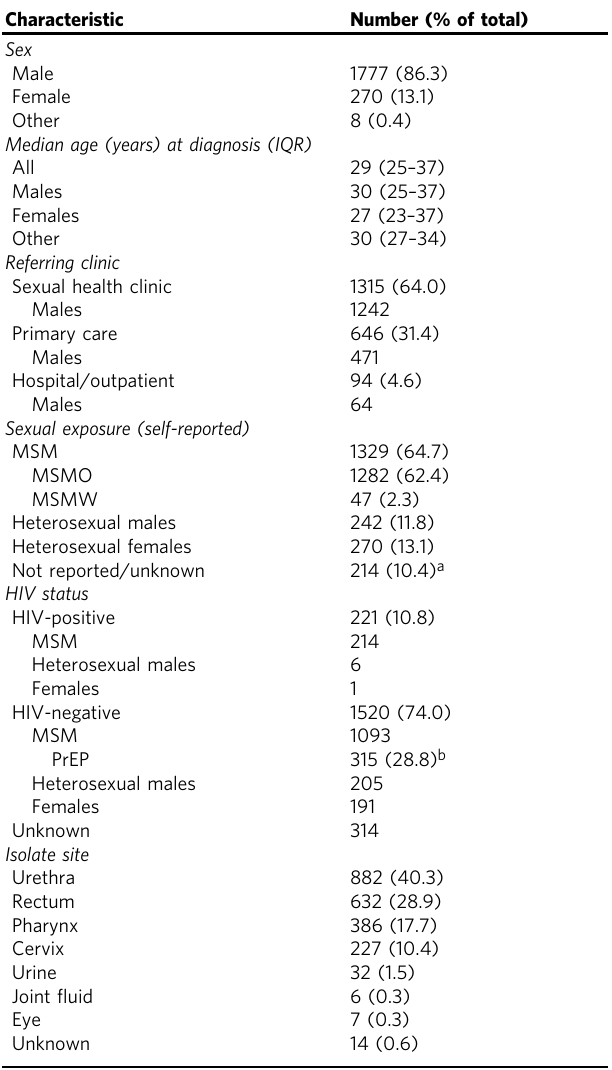
Table 1 Characteristics of Neisseria gonorrhoeae patients and isolates included in this study